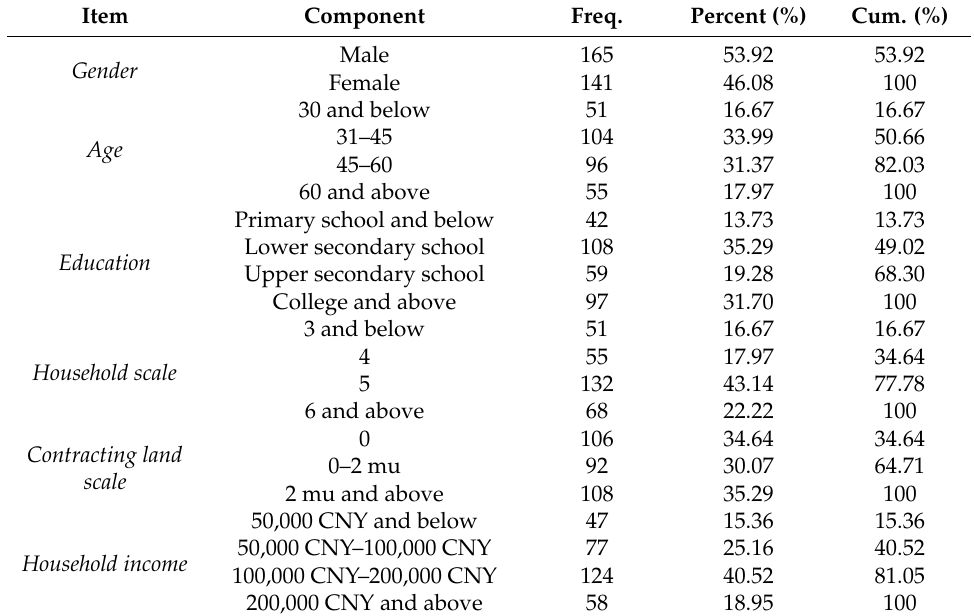
Table 2. Basic information of the survey subjects.